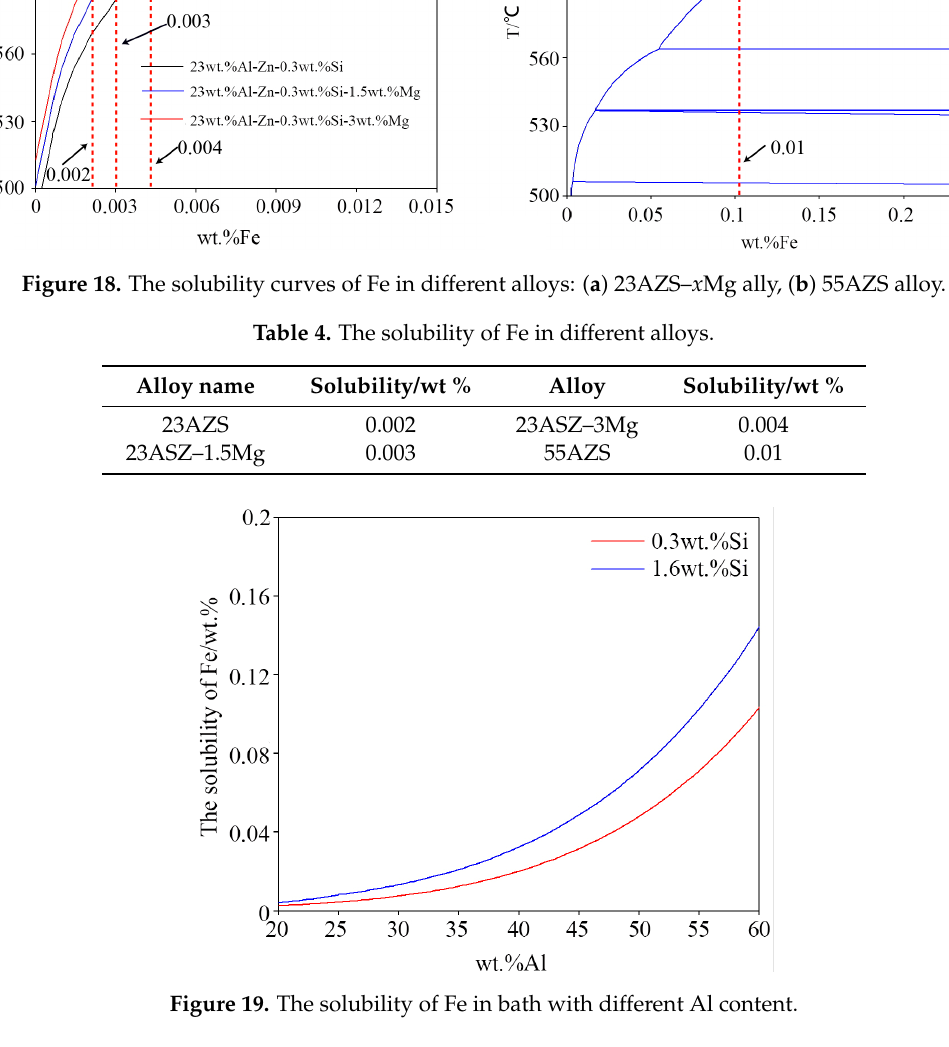
Figure 20. The fraction of Fe 4 Al 13 and Al 9 Fe 2 Si 2 phases. The dross composition of 22.3Al–Zn–0.6Si (wt %) at a temperature range of 480–620 °C is studied by Pan et al., and the result shows that the zinc dross formed on surface of 22.3Al–Zn–0.6Si (wt %) at 620 °C is composed of τ 2 and FeAl 3 phases [39], while τ 5 and FeAl 3 are the main phases formed on 22.3Al–Zn–0.3 Si (wt %) alloy. The possible reason is the different Si content and temperature. Otherwise, the corrosion potentials of dross phase have been reported by many researchers, and the result is shown in Table 5. It could be inferred that corrosion potentials of Mg 2 Si MgZn 2 , Al, and Al(Zn) phases are lower than the Fe phase. However, the Si, Fe–Al, and Fe–Al–Si phases are opposite. Therefore, some dross phase, such as Mg 2 Si MgZn 2 , Al, and Al(Zn), can provide cathodic protection,